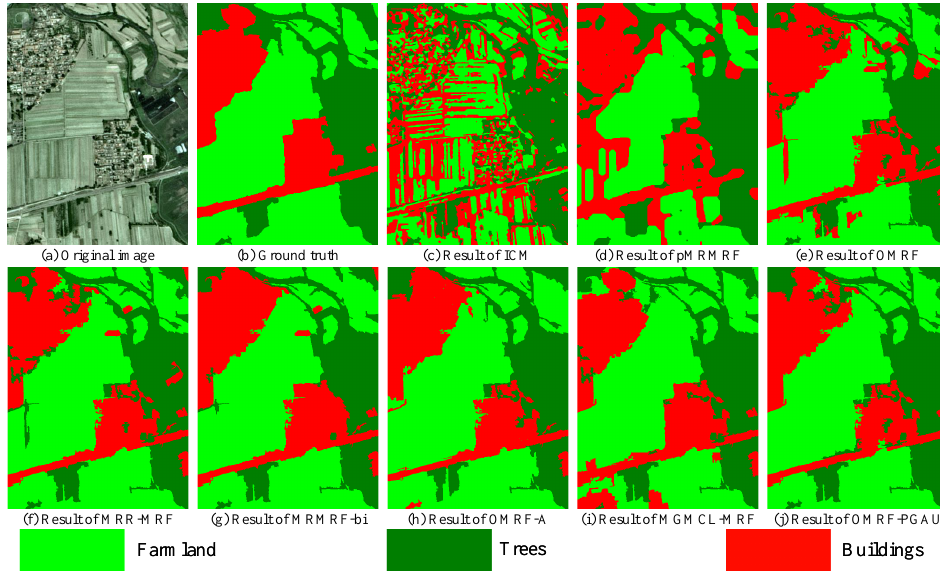
Figure 9. Semantic segmentation results for small size SPOT5